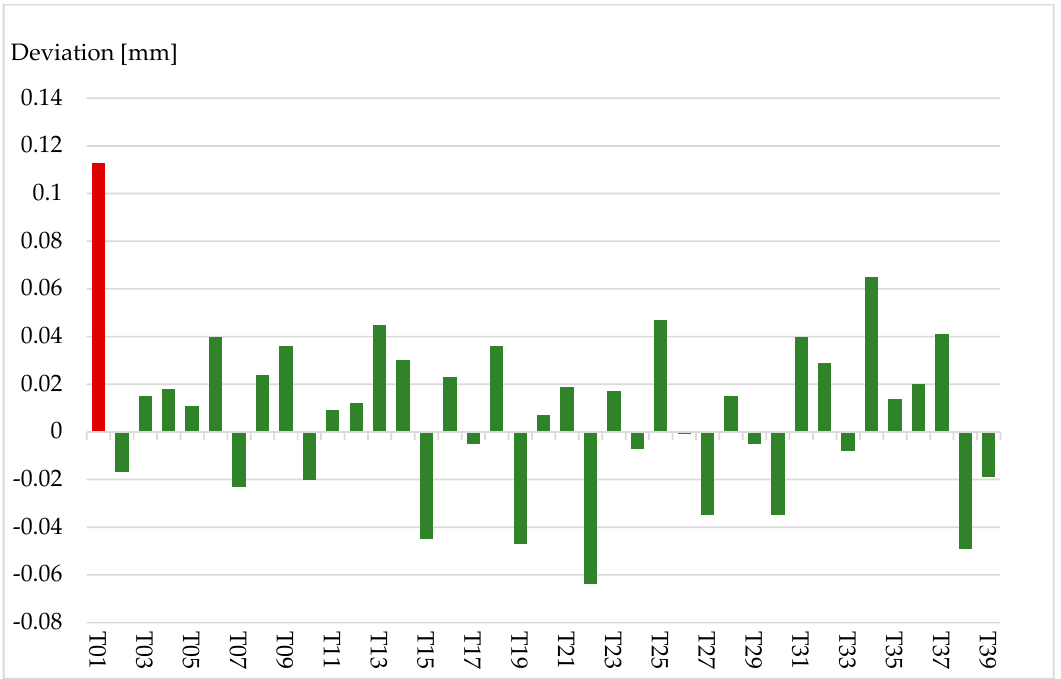
Figure 12. Deviation of target radius to CCR-radius for the targets T1–T39 in [mm].